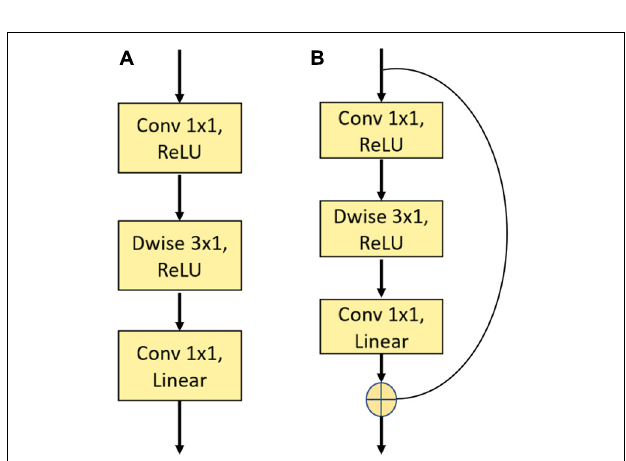
FIGURE 4 | Illustration of a single depth-wise convolution block and residual block. (A) The construction of the Depth-wise (Dwise) convolution block denoting a convolutional layer with a convolution group number set as input channels. (B) The construction of the residual block. “Linear” means that there is no use of an activation